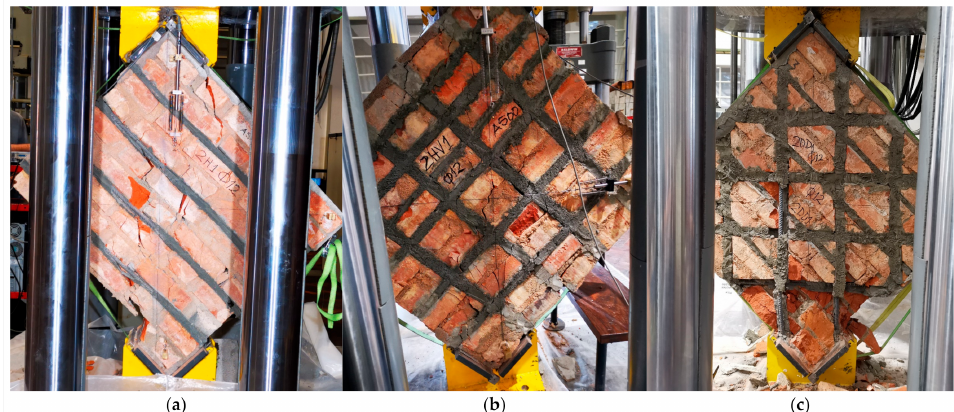
Figure 15. Crack patterns of the wallettes reinforced with SB in diagonal compression test. ( a ) 2H1;